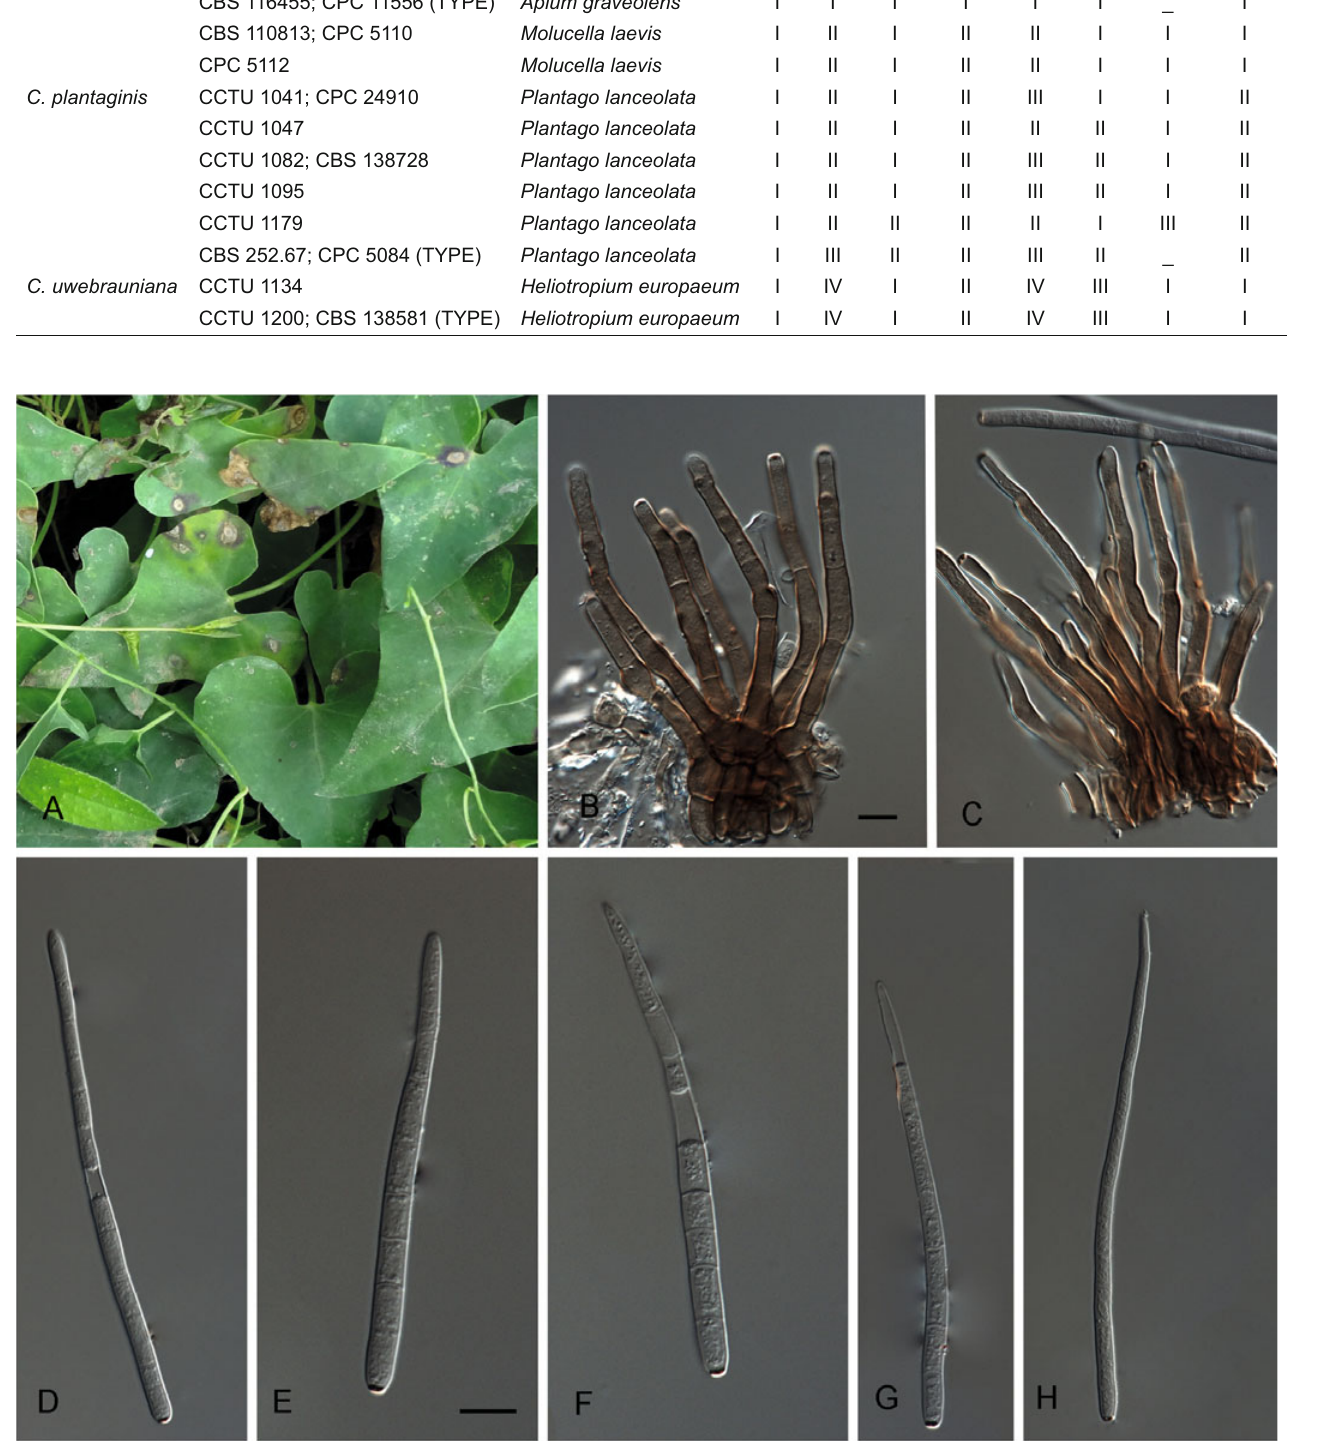
Fig. 2. Cercospora apii (cid:2)(cid:24)%’7(cid:2)!.$+.#(cid:27)(cid:28)(cid:2) A. S(cid:13)(cid:9)(cid:26)(cid:2)(cid:7)(cid:18)(cid:4)(cid:8)(cid:7)(cid:28)(cid:2) B–C. (cid:2)2(cid:9)(cid:7)(cid:19)(cid:11)(cid:19)(cid:5)(cid:23)(cid:9)(cid:8)(cid:13)(cid:2)(cid:19)(cid:4)(cid:17)(cid:11)(cid:21)(cid:11)(cid:4)(cid:18)(cid:14)(cid:4)(cid:10)(cid:13)(cid:7)(cid:28)(cid:2) D–H.